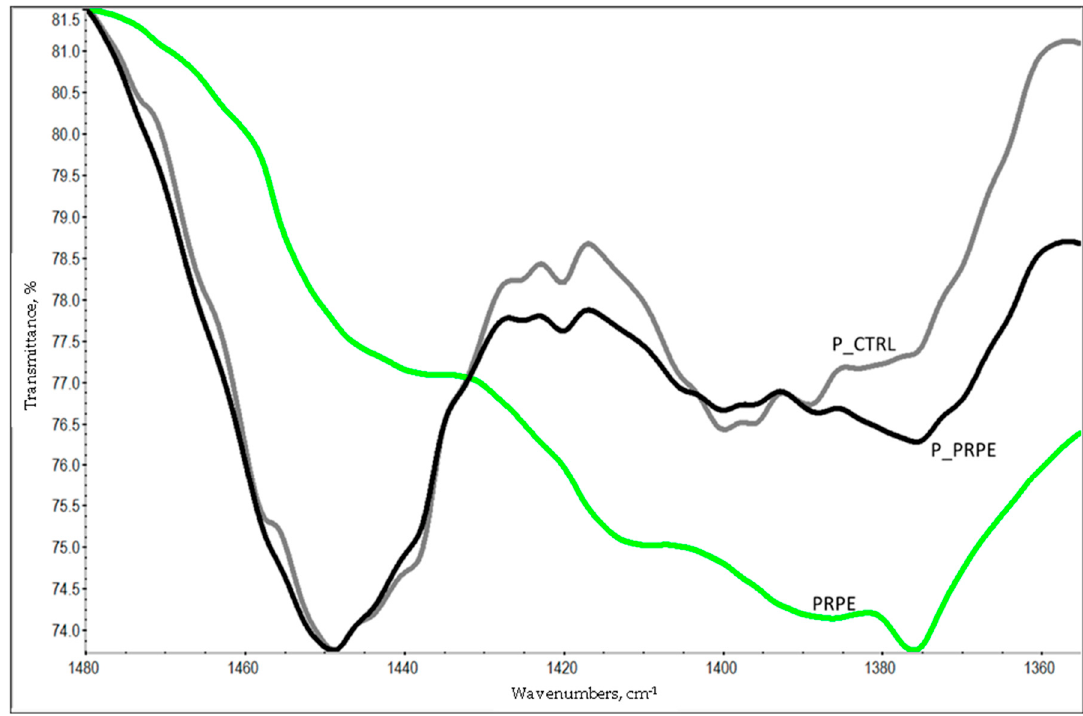
Figure 6. ATR-IR of P_CTRL and P_PRPE and PRPE between 1480 and 1350 cm − 1.